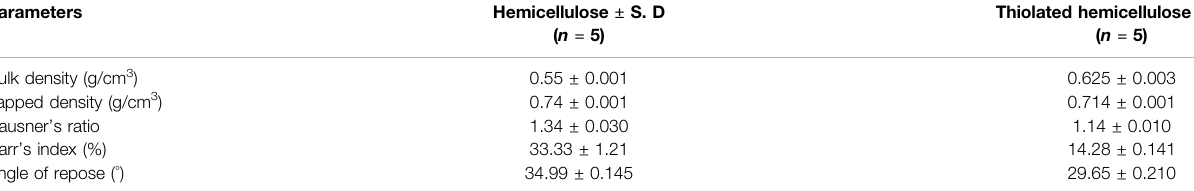
TABLE 3 | Micromeritics analysis of hemicellulose and thiolated hemicellulose. Parameters